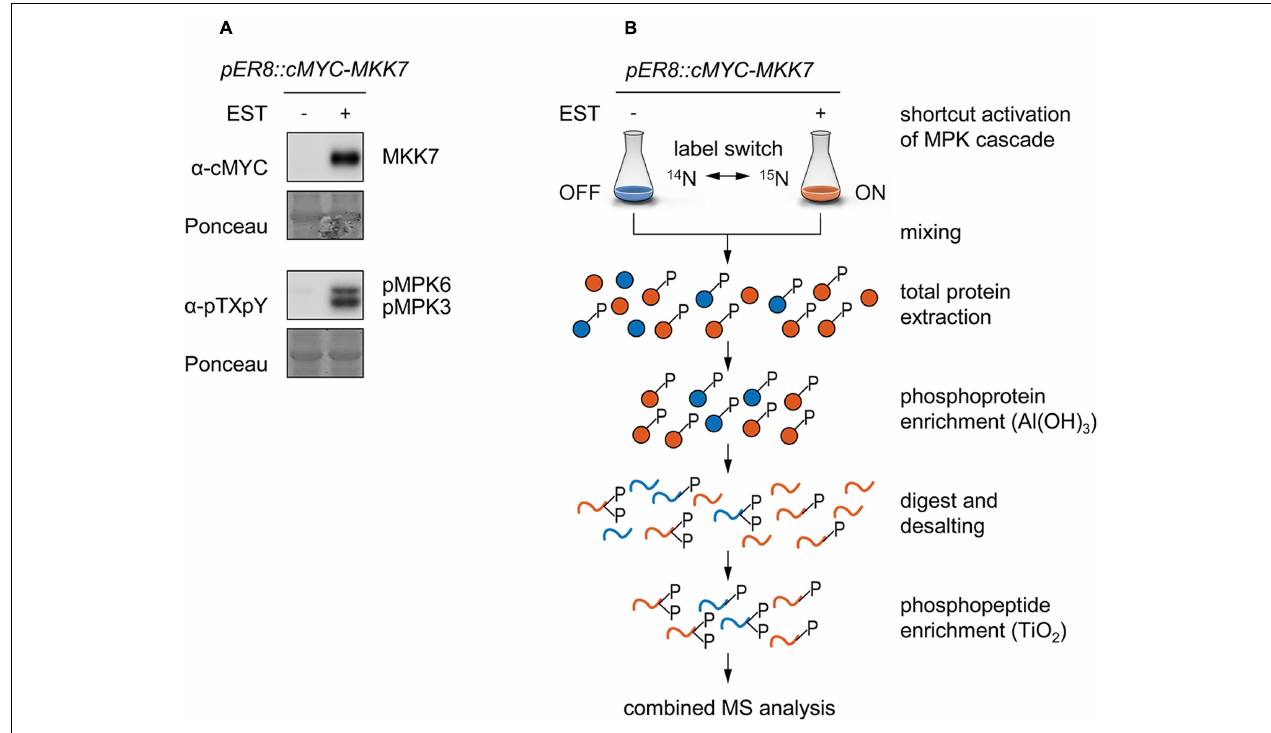
FIGURE 1 | Metabolic labeling combined with tandemMOAC to identify phosphorylation substrates of MKK7-MPK3/6. Twelve-day old pER8::cMYC-MKK7 seedlings were treated with ethanol as a control ( − ) or with 1 µ M β -estradiol ( + ) to activate cMYC-MKK7 transgene expression. Six hours later, seedlings were harvested and ground in liquid nitrogen to a fine powder. (A) Total protein was extracted and analyzed by SDS-PAGE, western blotting analysis, and immunodetection with antibodies to examine expression of the transgene (cMYC) and phosphorylation of MPK3/6 (pTXpY). The membrane was subjected to Ponceau S staining to check equal gel loading. (B) Reciprocal 14 N- and 15 N-labeled Arabidopsis seedlings were ground separately and subsequently mixed in a 1:1 (w/w) ratio. Total protein was extracted, phosphoproteins enriched via Al(OH) 3 -based MOAC and digested with trypsin before peptides were desalted using graphite columns. After TiO 2 -based MOAC enrichment of phosphopeptides, samples were analyzed by